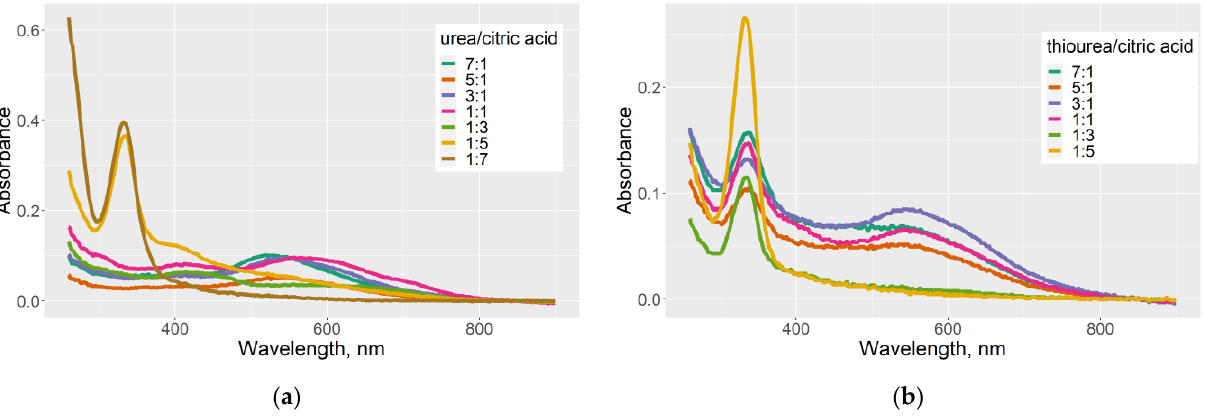
Figure 4. Electronic absorption spectra of the purified samples. Initial mixture composition is marked in the legend. ( a ) Products of solvothermal treatment of mixtures of urea with citric acid; ( b ) Products of solvothermal treatment of mixtures of thiourea with citric acid.